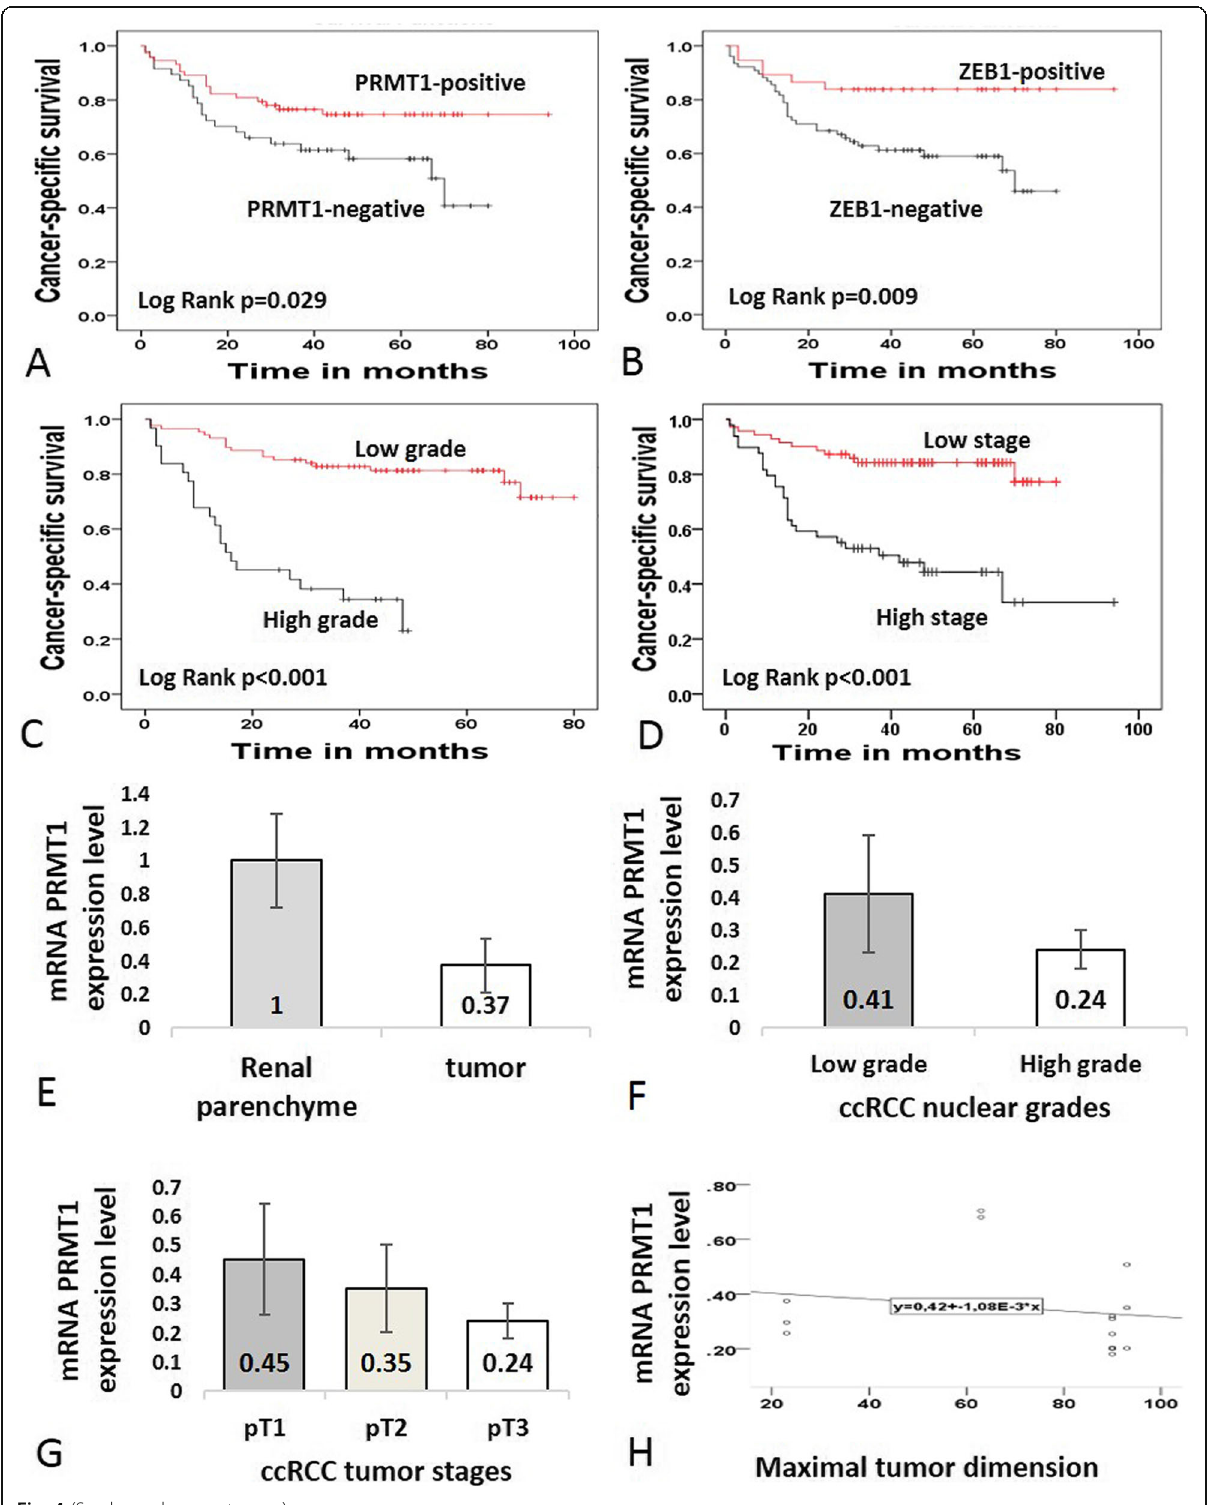
Fig. 4 (See legend on next